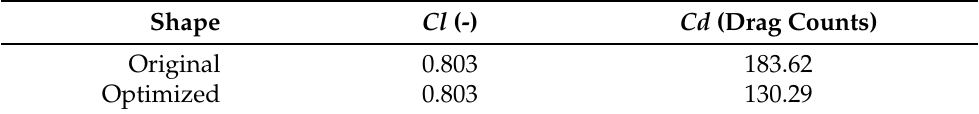
Table 5. Aerodynamic coefficients for the second case optimized airfoil’s